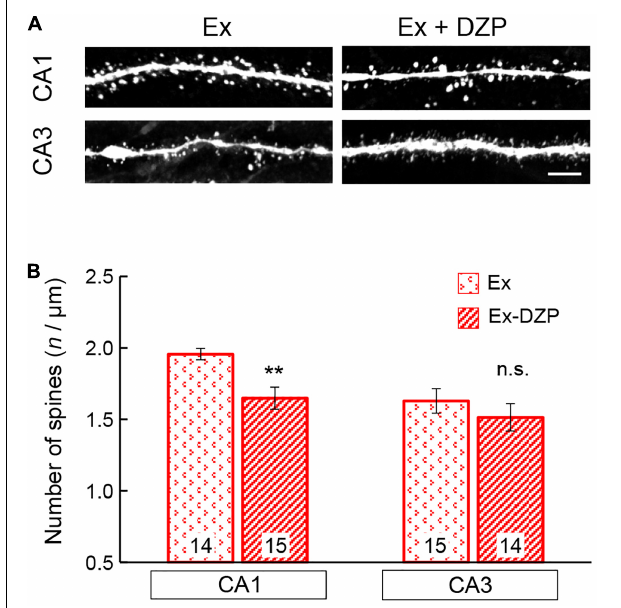
FIGURE 6 | Effects of exercise on the spine density of hippocampal neurons in middle-aged mice. (A) Representative images of visualized spines in the CA1 and CA3 regions of middle-aged mice. (B) Spine density was measured and is summarized in a bar graph. The number in bar graph indicate the number of analyzed neurons ( N = 4 animals, 3–4 neurons/animal). Scale bar, 5 µ m. Error bar: mean ± SEM. ** P < 0.01, t -test, vs. Ex group; n.s., not significant. Ex, exercise group; Ex + DZP, exercise + diazepam